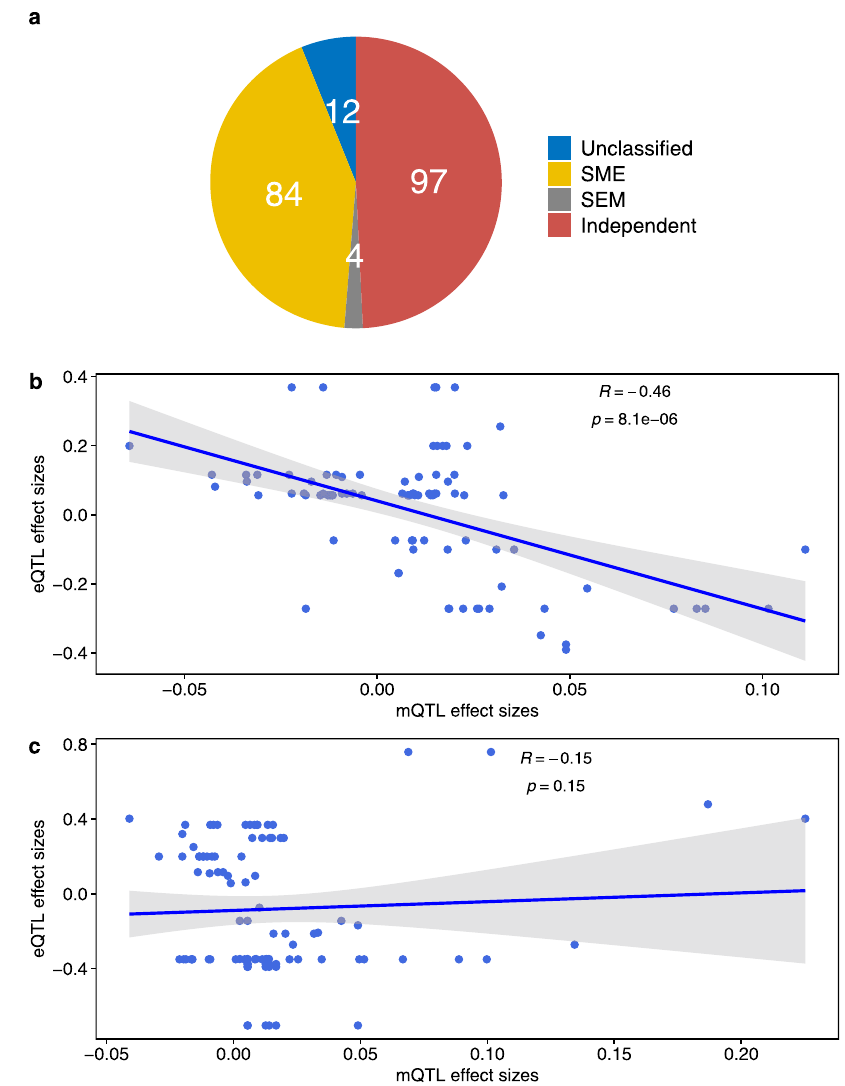
Fig. 3 Causal inference test result. a Pie-chart showing the number of eQTL-mQTL triplets predicted as “ SEM ” mediation representing SNP effect mediated via placental gene expression on nearby DNA methylation, “ SME ” mediation representing SNP effect mediated via placental DNA methylation on placental gene expression, “ independent SE/SM ” effect denoting SNP effect on placental DNA methylation and gene expression via independent pathways, and “ unclassi fi ed ” relationship. b , c Error bands in gray represent standard error of the mean and P is based on a two-sided Spearman correlation test. The dose-response correlation between eQTL and mQTL association coef fi cients was only signi fi cant for triplets with SEM or SME predicted causal relationship ( b ) but not with independent SE/SM relationship ( c